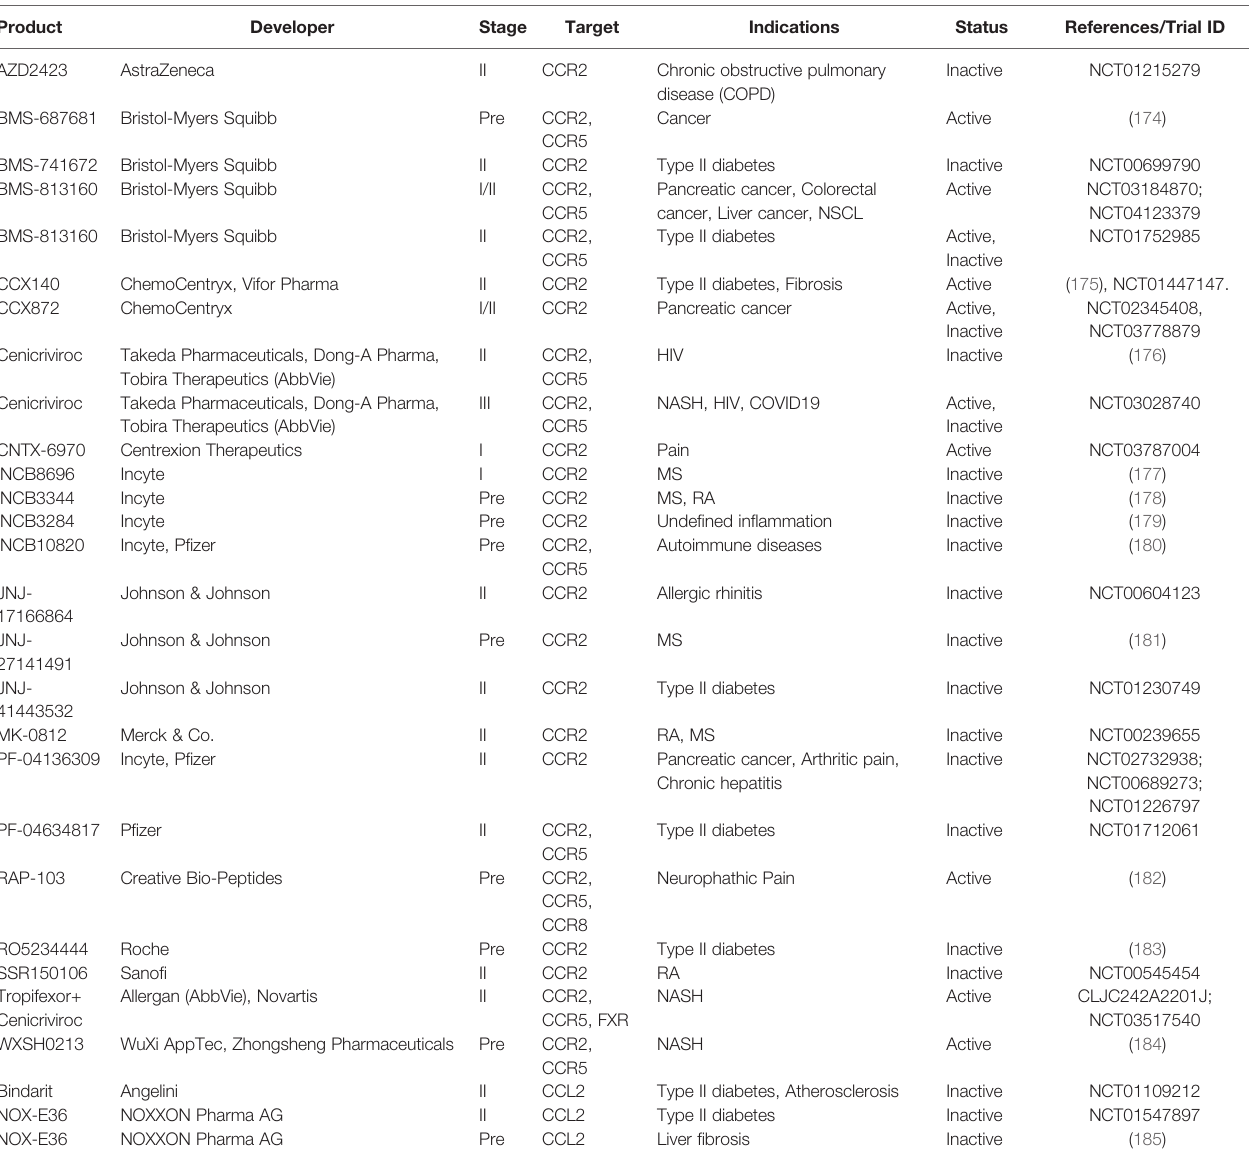
TABLE 2 | Antagonists targeting CCR2-CCL2 axis. Product